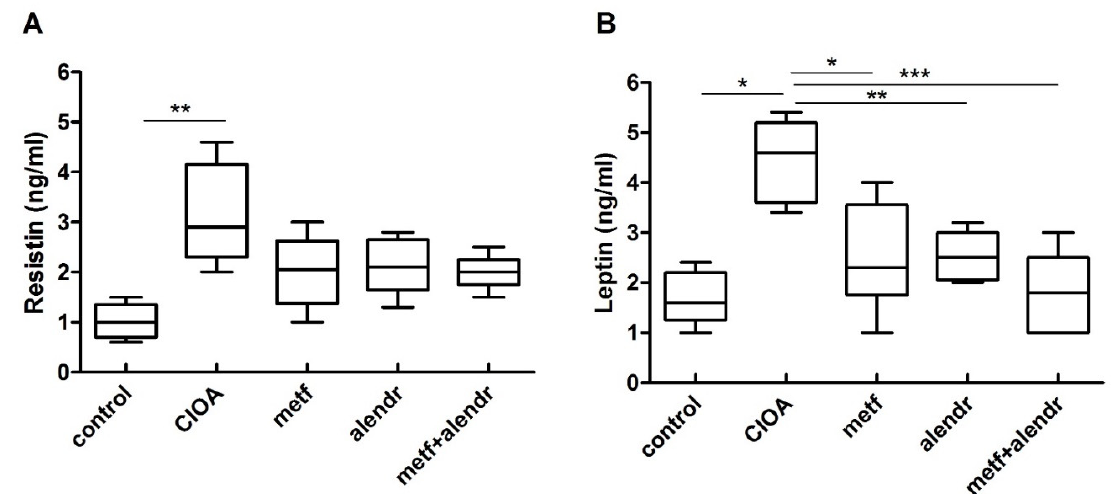
Figure 3. Serum resistin ( A ) and leptin ( B ) levels at day 30 of CIOA. Data are means ± SD from three determinations ( n = 10 per group). * p < 0.05, ** p < 0.01, *** p < 0.001, one-way ANOVA. (CIOA = collagenase-induced osteoarthritis; metf = metformin; alendr = alendronate).